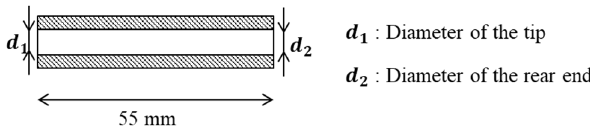
Figure 7. Longitudinal cross-sectional view of TSMD inlet. Table 1. Parameters for various simulation